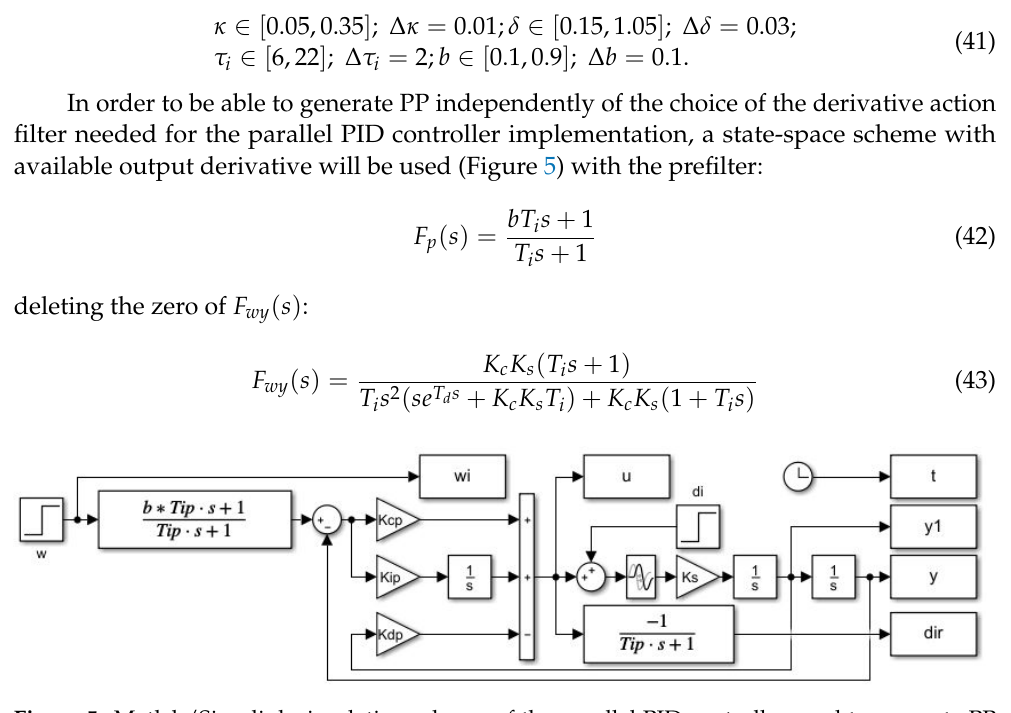
Figure 5. Matlab/Simulink simulation scheme of the parallel PID controller used to generate PP (41) with the prefilter F p ( s ) = ( 1 + bT ip s ) / ( 1 + T ip s ) (42) and an additional low-pass filter used for disturbance